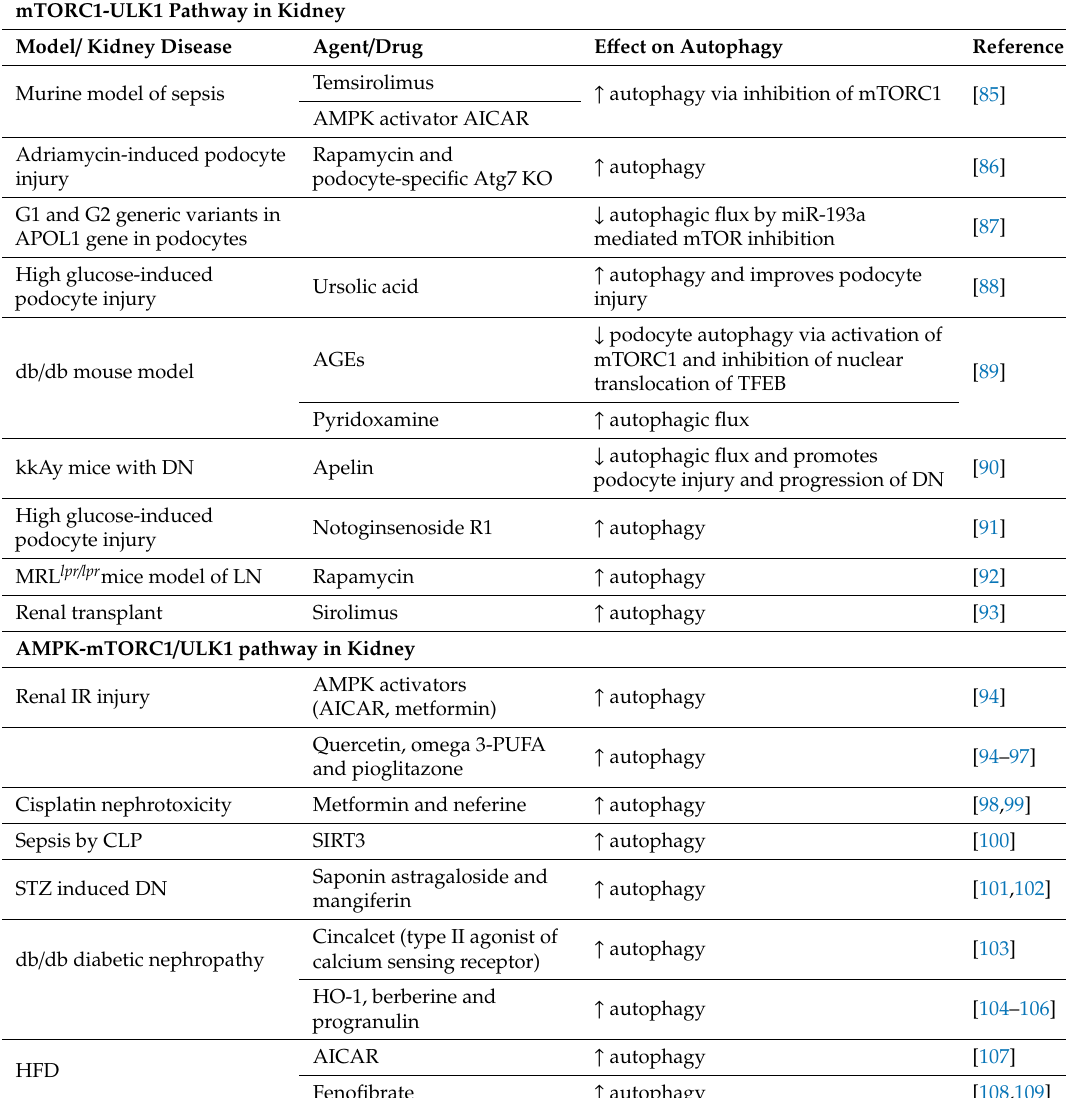
Table 2. mTORC1-dependent autophagy regulation in kidney